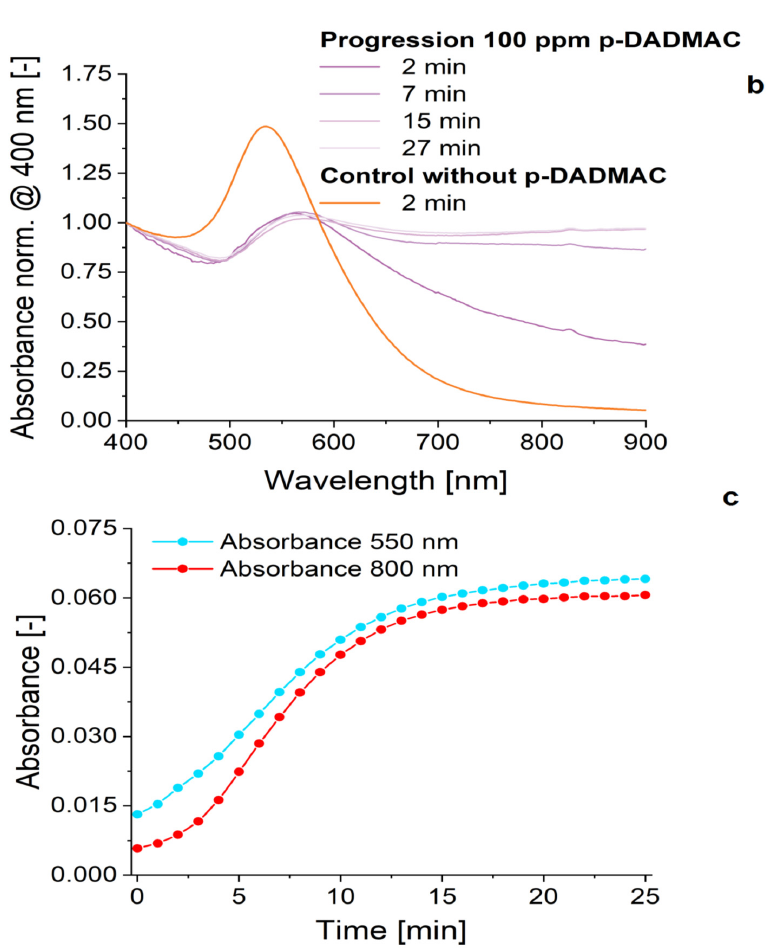
Figure 7. Effect of poly-DADMAC on the evolution of the characteristic electromagnetic resonance of forming gold nanoparticles (70 µM HAuCl 4 , 60 µM ascorbic acid). ( a ) Evolution of the spectra over time, ( b ) evolution of the normalized spectra over time (normalized to 400 nm) and ( c ) fast initial growth of the absorbance at 550 nm and increasing growth rate of NIR absorbance.